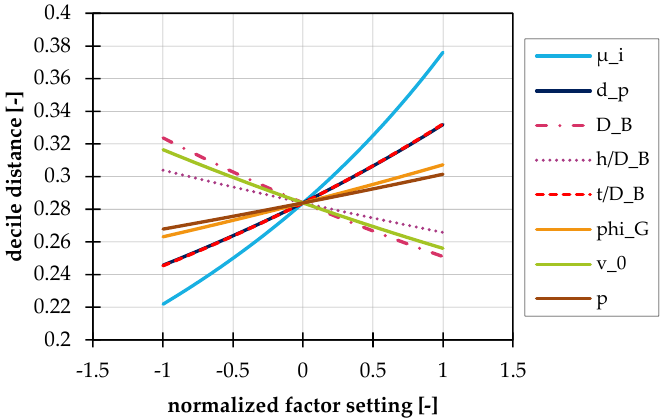
Figure 9. Perturbation plot of the decile distance of the normalized axial velocity in dependence on the normalized factor setting.